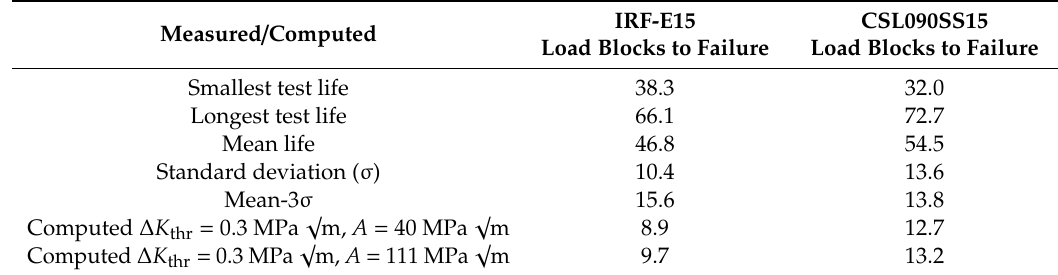
Table 3. The values of A and ∆ K thr and A used in Figure 14.